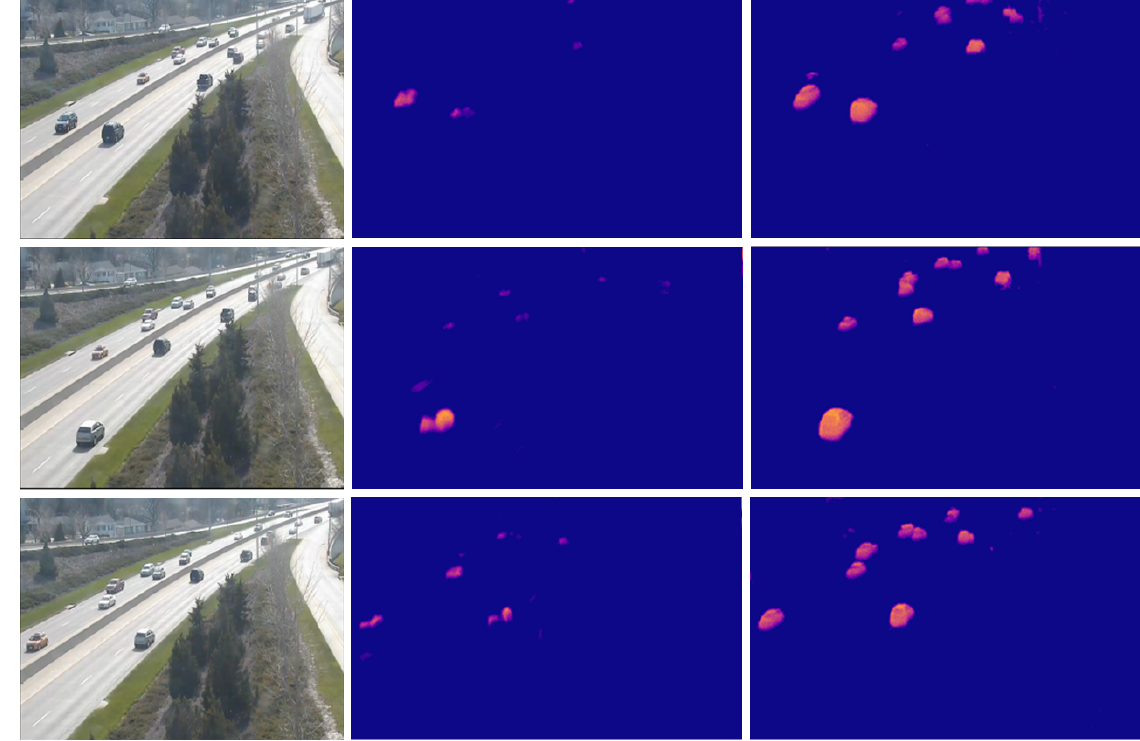
Figure 5. Original image ( Left ); Kitti-based results ( Middle ); CARLA-based results ( Right